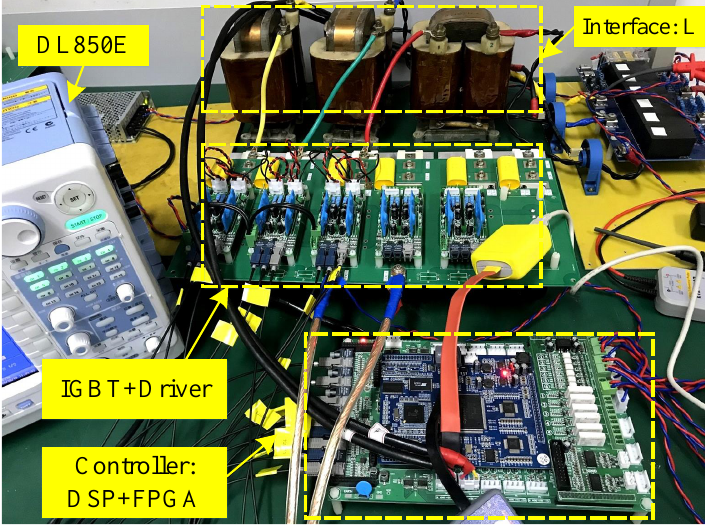
Figure 15. Experimental setup of the